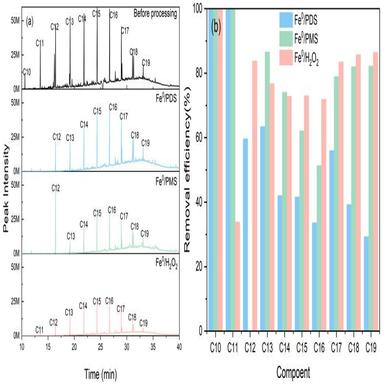
GC-MS traces (a) and petroleum hydrocarbon compositions (b) before and after the degradation of petroleum hydrocarbons in OBDC by the Fe0 /PMS, Fe0 / PDS, and Fe0 /H2O2 systems.